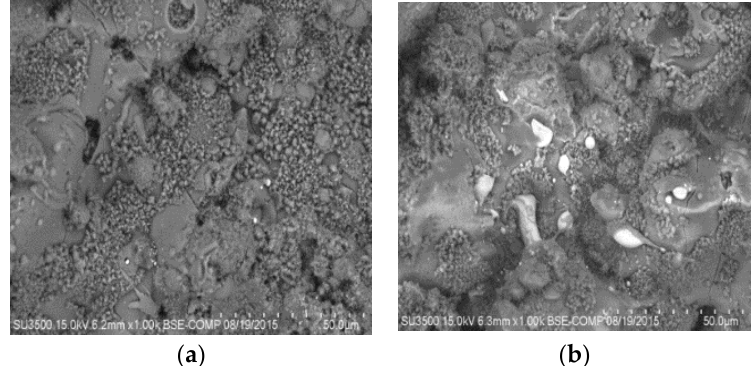
Figure 3. Scanning electron microscopy (SEM) micrographs of the HA/Ag-NPs coatings showing silver. ( a ) zone 1; ( b ) zone 2.